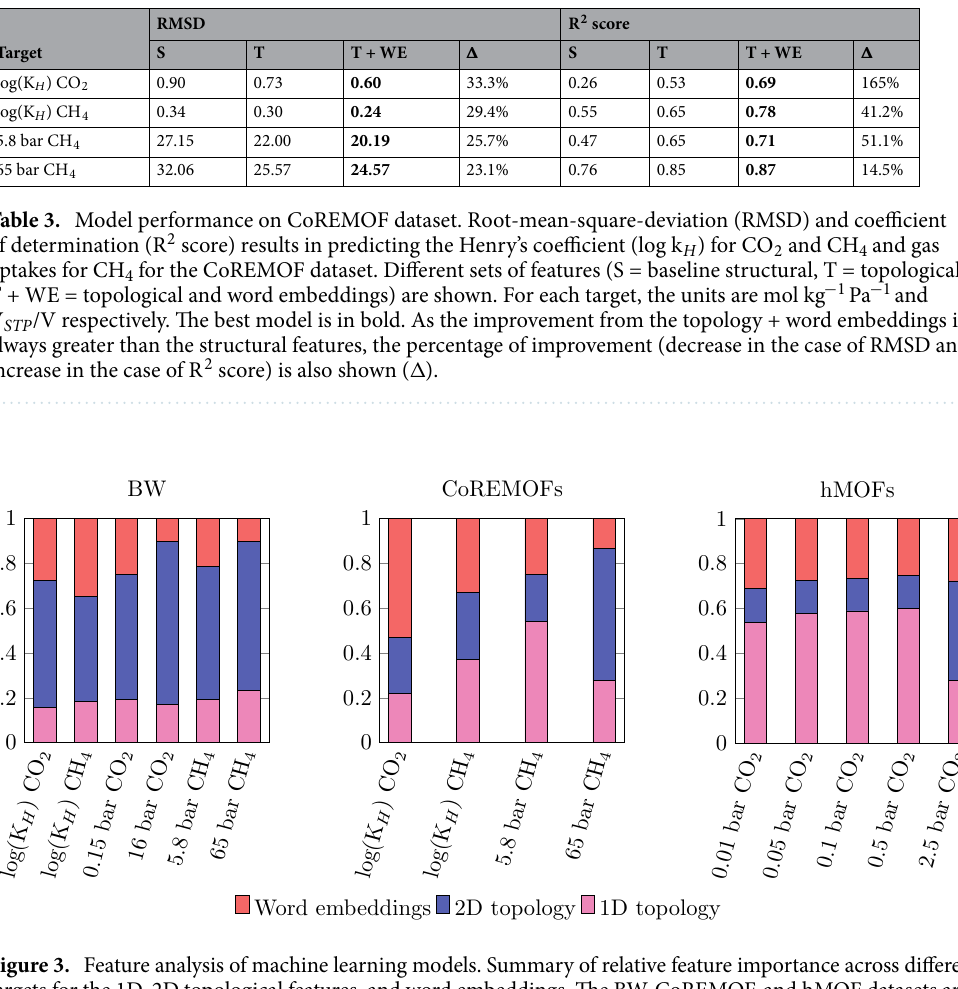
Figure 3. Feature analysis of machine learning models. Summary of relative feature importance across different targets for the 1D, 2D topological features, and word embeddings. The BW, CoREMOF, and hMOF datasets are shown